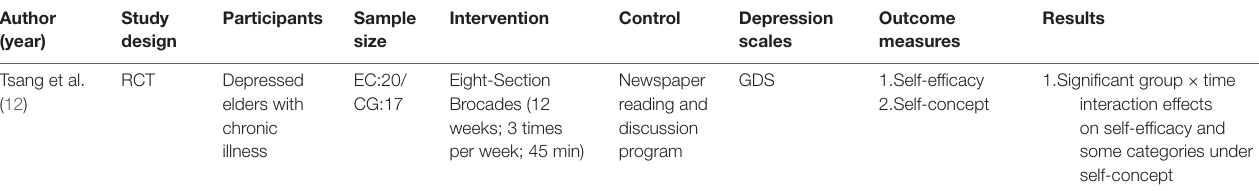
TABLe 3 | Summary of the psychological mechanism of qigong.